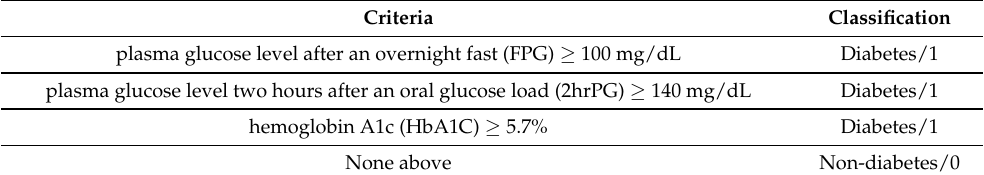
Table 1. The Clinical guideline used to define Diabetes/Non-diabetes (preDM/DM)